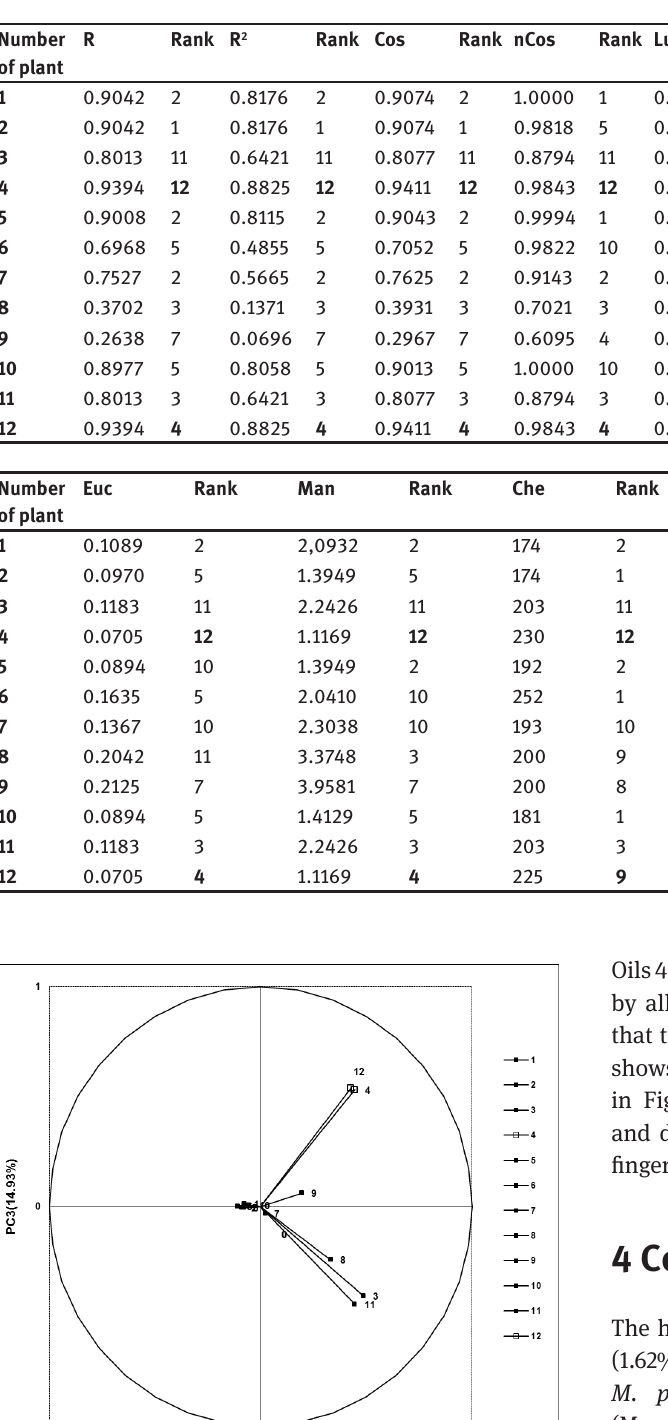
Table 4: GC-MS chromatogram similarity measures and best matching. Numbering as in Table 1; abbreviations as in Experimental section.